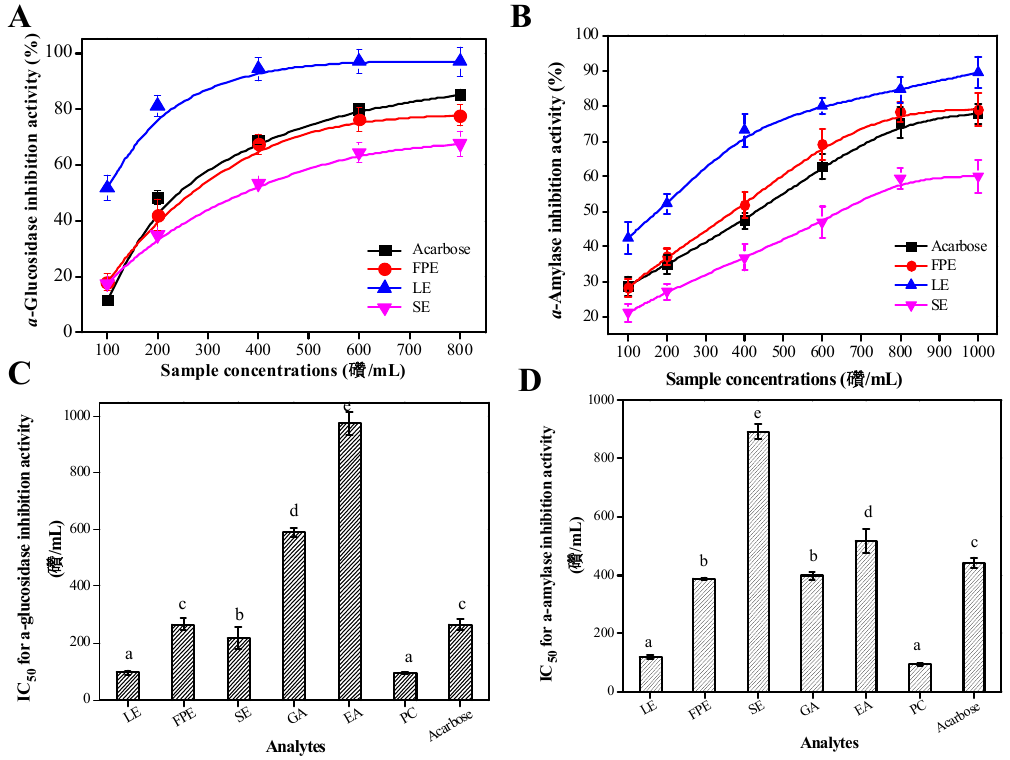
Figure 4. The digestive enzymes inhibitory abilities of various parts extracts in raspberry and acarbose: α -glucosidase inhibitory activity ( A ) and α -amylase inhibitory activity ( B ). Figure 4C,D represents the corresponding IC 50 values of the samples/controls. LE, leaves extracts; FPE, fruit pulp extracts; SE, seed extracts; GA, gallic acid; EA, ellagic acid; PC, procyanidin C3. Different lowercase letters (a–e) mean statistically significant differences following different samples.